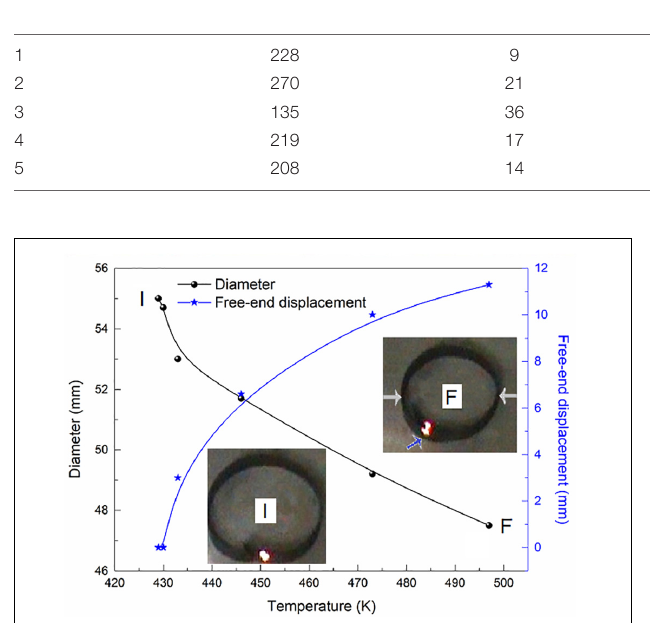
FIGURE 14 | Details of the training procedure applied to a 50_MA pipe-coupling ring subjected to free recovery SME, with opposite gray horizontal arrows indicating diameter shrinkage and blue tilted arrow emphasizing free-end displacement, from initial (I) to final (F) stages and variations of diameter and free-end displacement, during heating (modified after Bujoreanu,